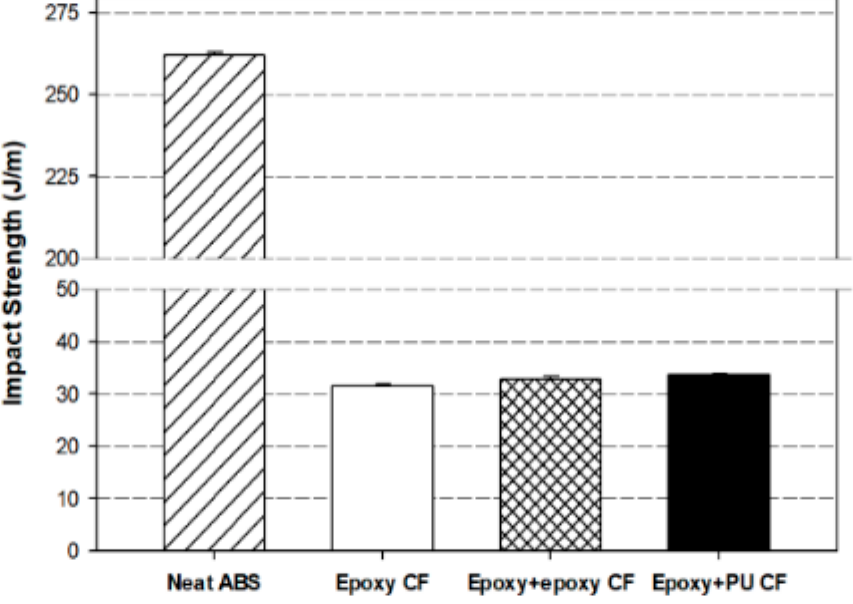
Figure 10. Izod impact strengths of neat ABS and carbon fiber/ABS composites with (epoxy) single-sized and (epoxy + epoxy, epoxy + PU) dual-sized carbon fibers.